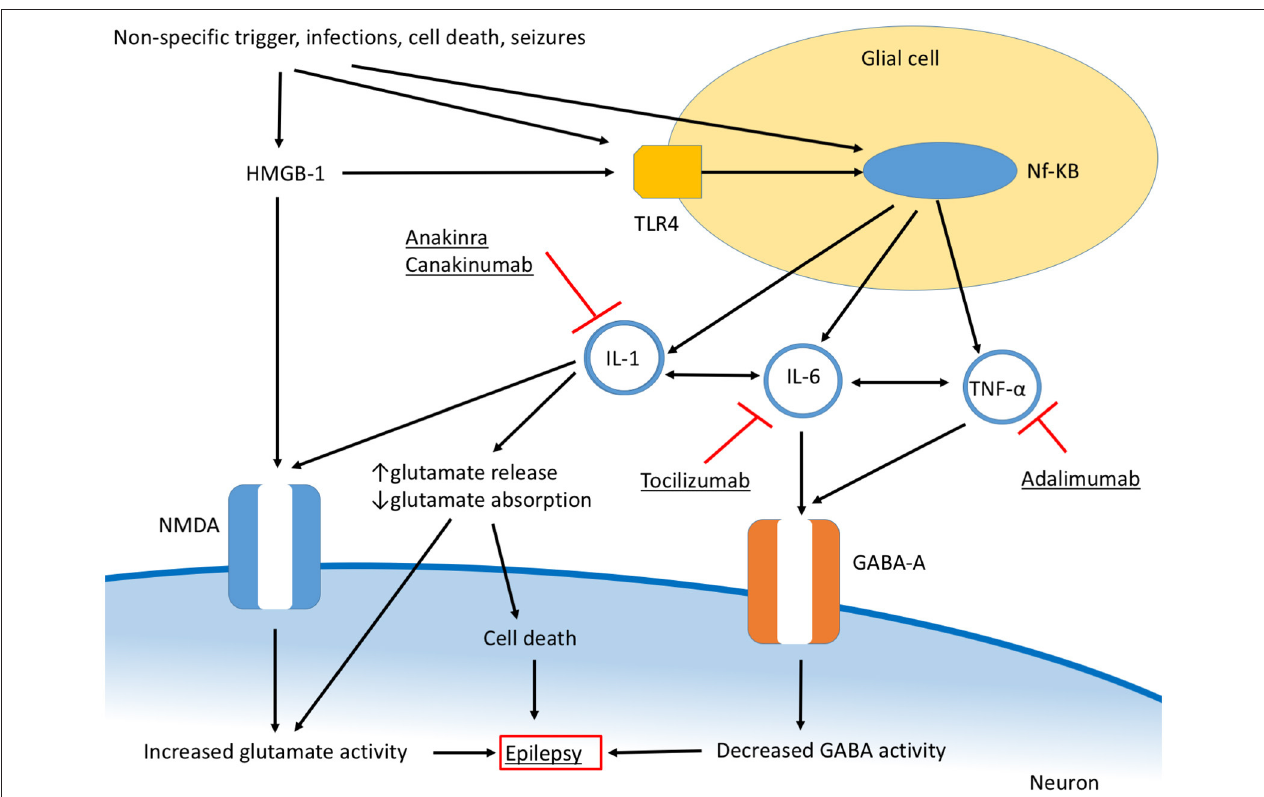
FIGURE 2 | Overview of inflammatory pathways involved in epilepsy and main therapeutic